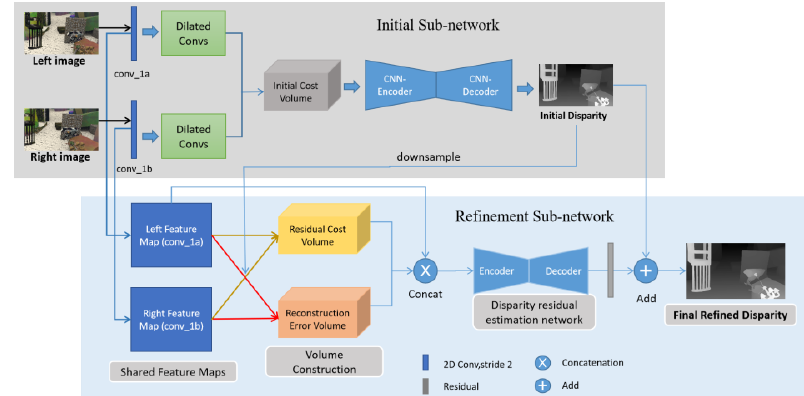
Figure 1. The overall architecture of our network. It consists of two parts, the initial sub-net and the refinement sub-net. The inputs are two rectified images and the output is the final refined disparity map between the coarse initial disparity and the ground truth disparity and thus to explicitly refine the initial disparity. The inputs of this residual learning network are two original images, a warped right image, an error map and an initial disparity, which is somewhat redundant information. While stacking more networks together indeed improves accuracy, it